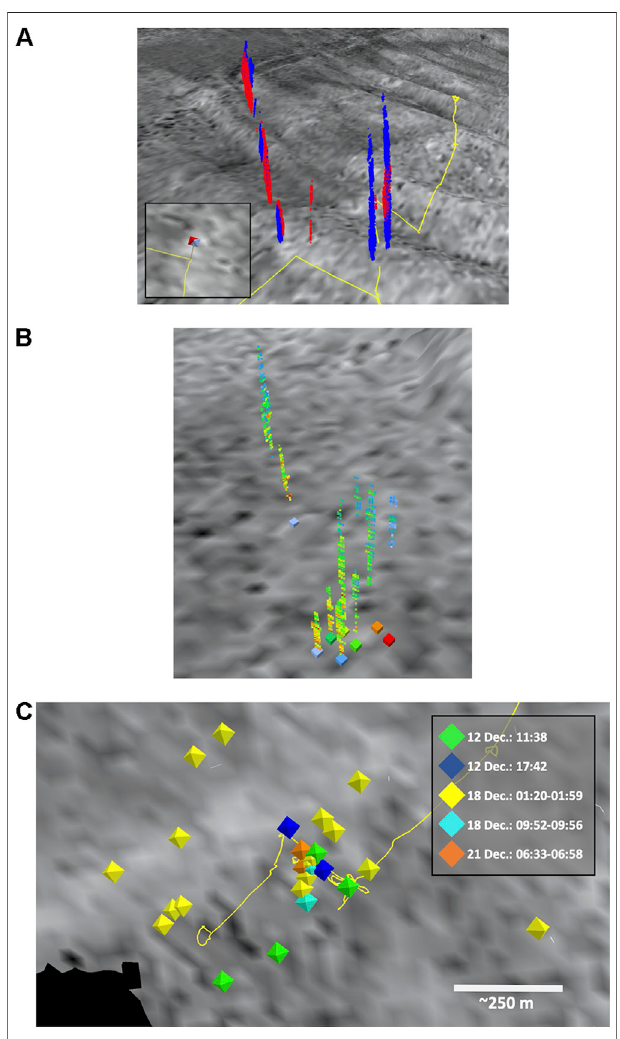
FIGURE 8 | (A) Comparison of EM302 (blue) and EM710 (red) bubble plumes in SA1: Pacuare. Excellent overlap of points recorded at same time supports interpretation that both sonars imaging same plumes. Plumes on left side near sharp corner in ROV path (yellow line) are SC2. Inset fi gure shows sea fl oor source of S1 (blue) and S2 (red). Distance along yellow ROV path between the two seep clusters ∼ 450 m. (B) Moderate con fi dence anomalies identi fi ed on EM710, SA2: Savegre- SC3. No comparable anomalies are apparent on EM302 data, offering evidence of false negative in 30 kHz data. Colors in water column anomalies represent acoustic backscatter amplitude with red colors at +10 dB and light blue colors at − 9 dB. Distance between main grouping of plumes and outlier plume ∼ 380 m (C) Time series of EM302 data, SA2: Savegre-SC2. While anomalies were observed at all times, number of anomalies varies over 9-days timespan.